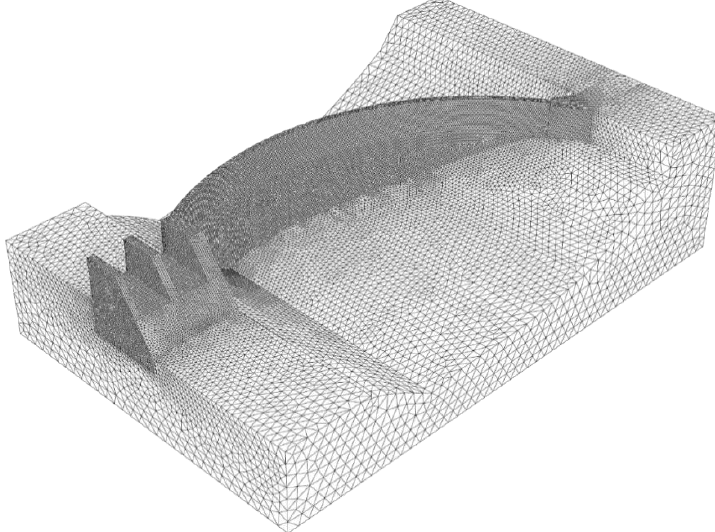
Figure 5. Illustration of the mesh provided to the contributors in the benchmark workshop.